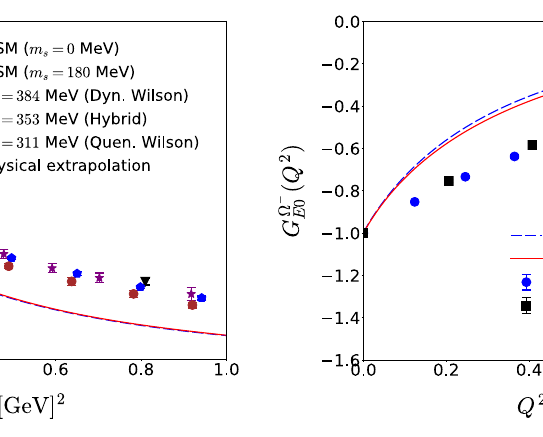
tors without the effects of the explicit flavor SU(3) symmetry breaking, whereas the solid ones present those with the effects. The lattice data are taken from Refs.